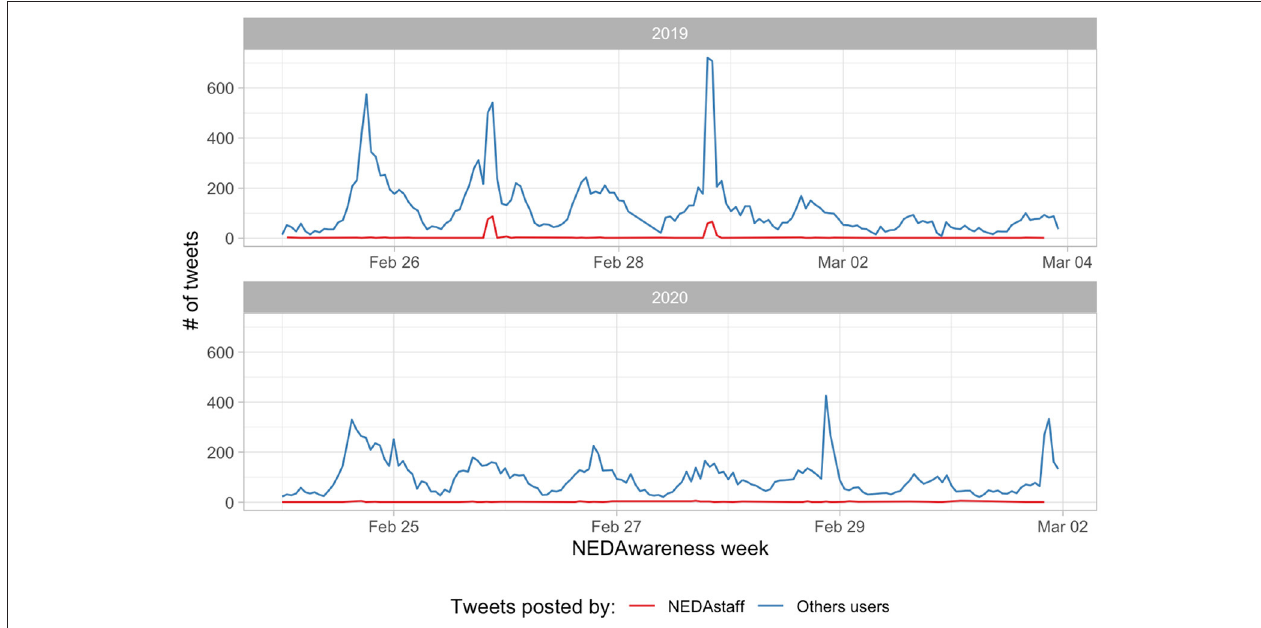
FIGURE 3 | Tweets per hour during the NEDAwareness week during 2019 and